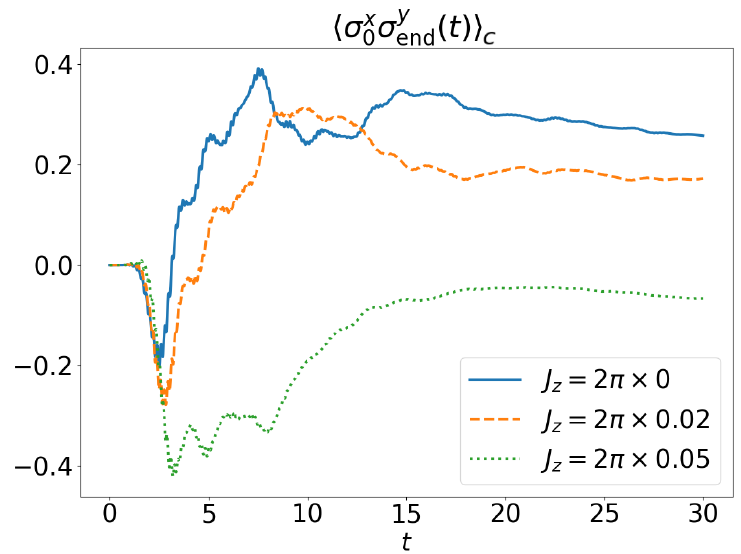
Figure 14: The two-qubit X Y connected correlation function of the two edge qubits vs. the time t , with N = 22 for a plaquette topology where the qubit frequencies alternate between nearest neighbors, which also coupled via ZZ interaction. The parameters are given in Eq. (38), with J indicated in the legend. As the ZZ coupling z strength is increased, the absolute value of the long-time correlation is gradually reduced.